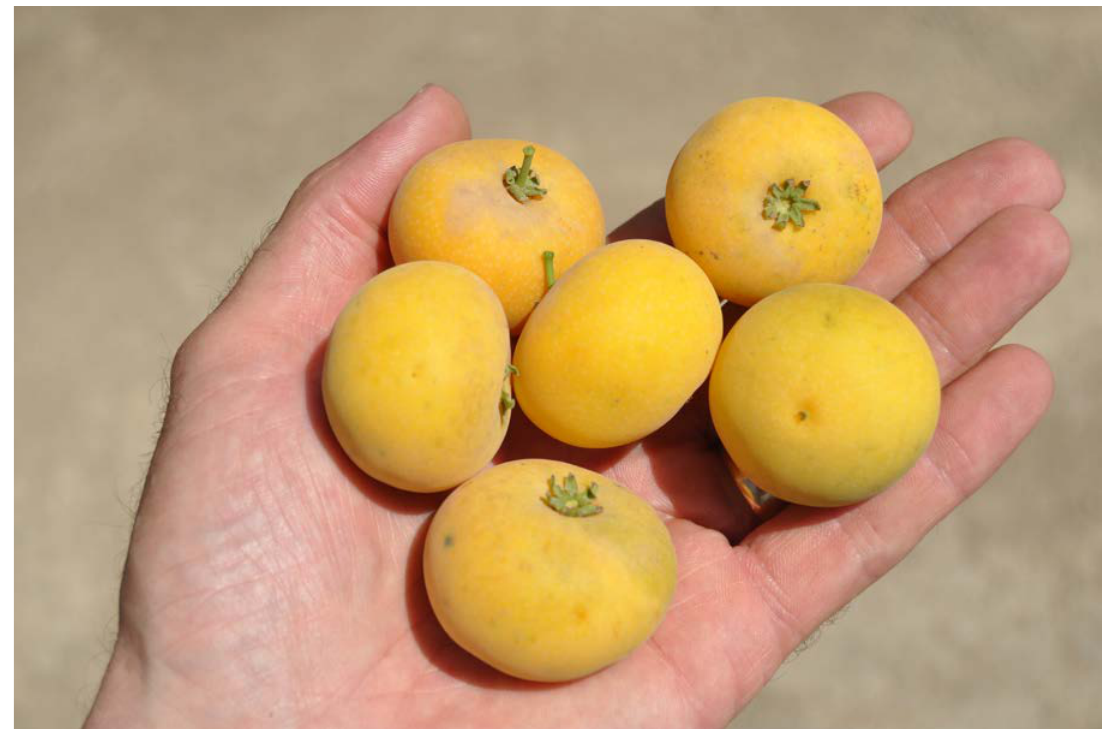
Figure 2. Dovyalis caffra (Hook.f. and Harv.) Hook.f., (Salicaceae). Image provided by Ben-Erik van Wyk.